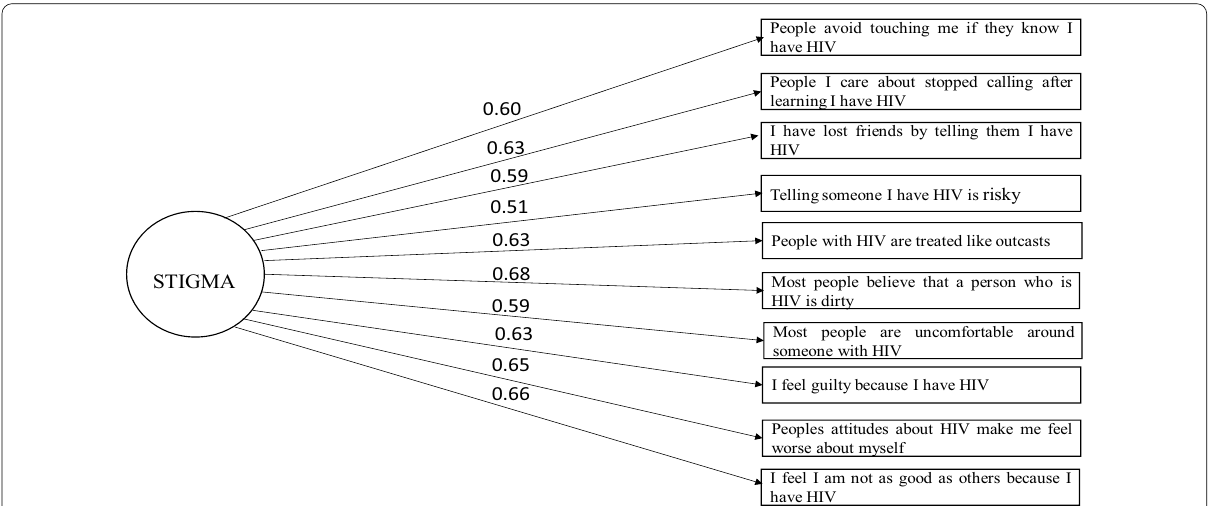
Fig. 2 Confirmatory factor analysis of the unidimensional HSS-10. Sample (n